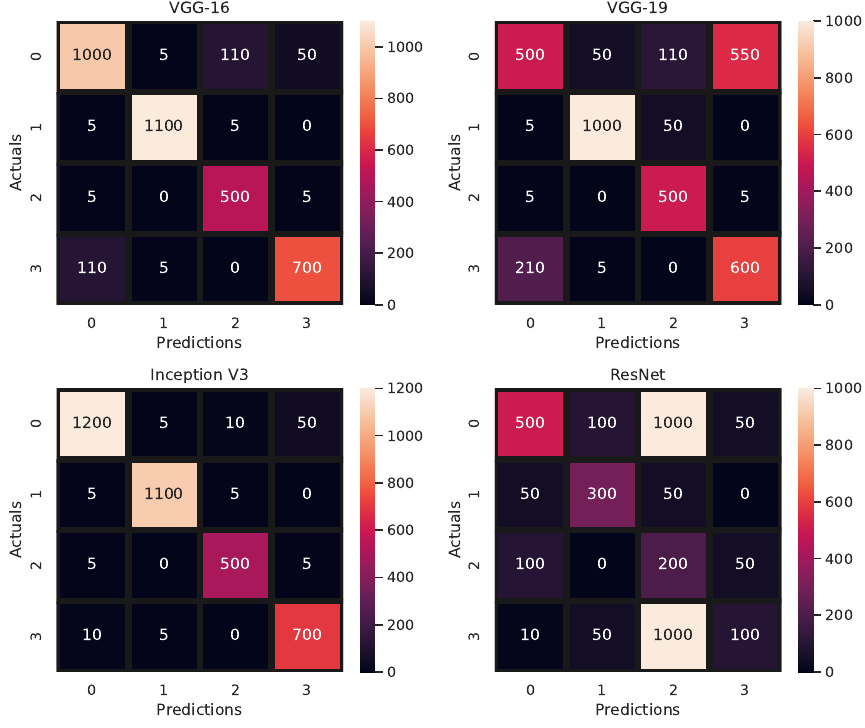
Figure 18. The confusion matrix analysis of applied neural network